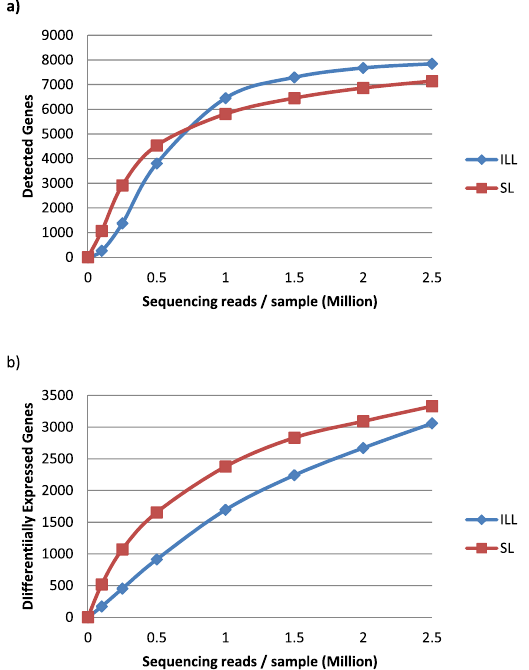
Figure 2. ( a ) Relation between the raw sequencing depth per sample and the amount of detected genes. Genes were considered detected if they had at least 10 counts in every sample. Every point represents a full differential expression analysis started from a specified amount of raw sequencing reads, sampled from the original files. ( b ) Relation between the raw sequencing depth per sample and the amount of detected differentially expressed genes (DESEQ2 FDR Adjusted p < 0.05) between LOG and STAT Leishmania